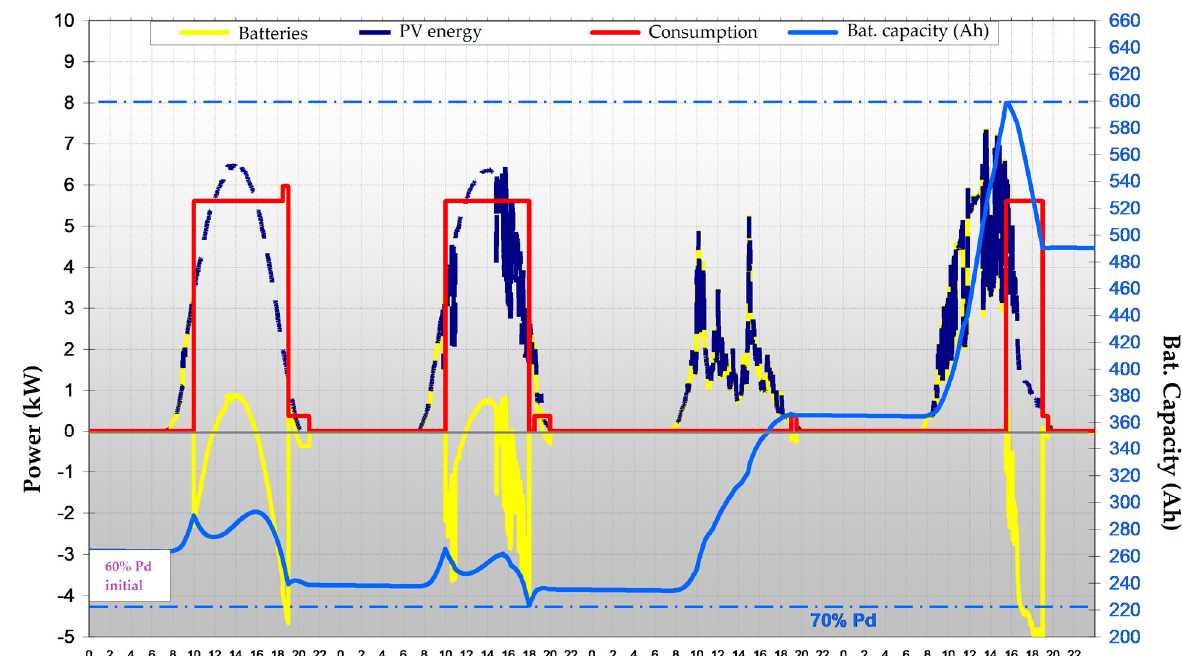
Figure 4. Selection of 4-day monitored data from an off-grid PV-powered RO system.